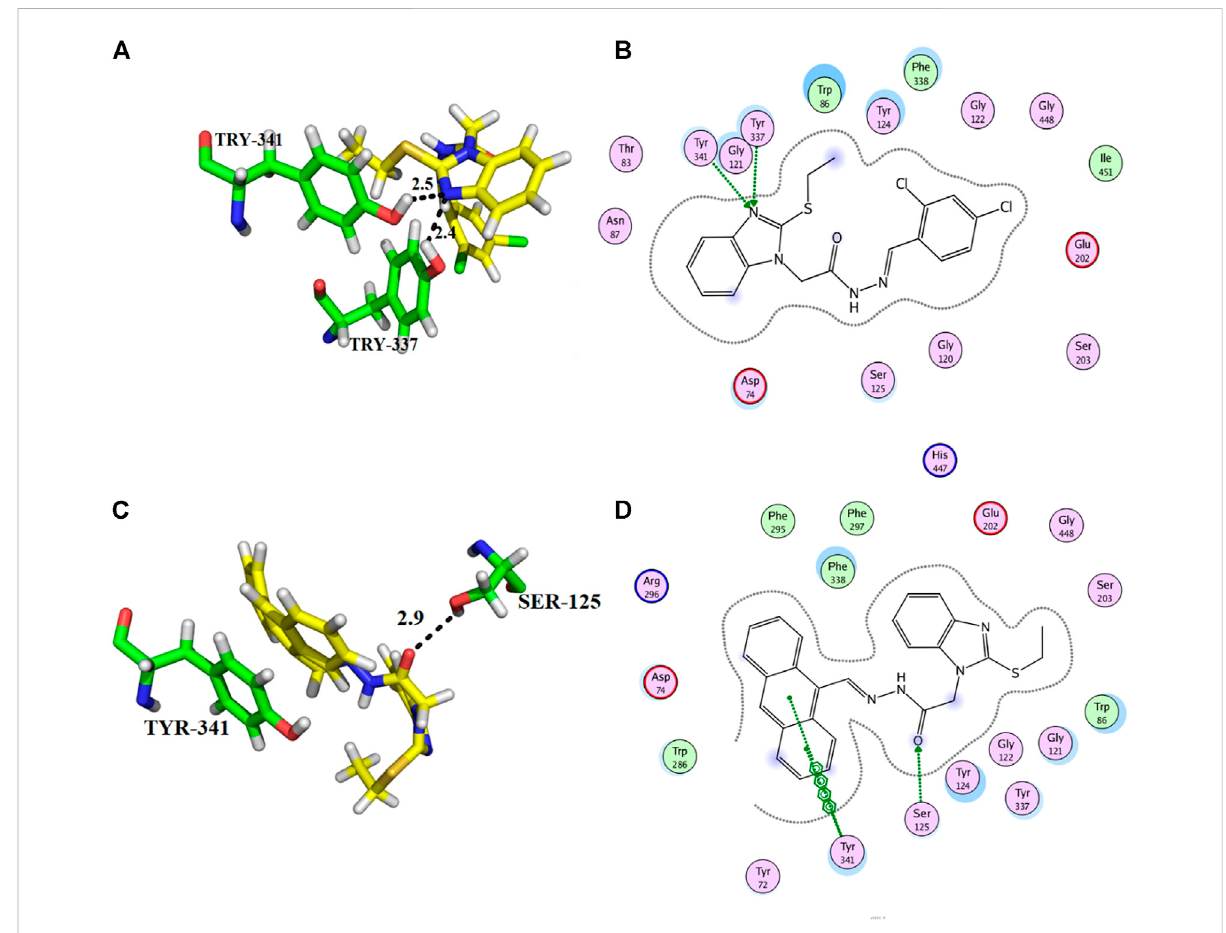
FIGURE 6 Showing the docking conformation of compound 10 (A,B) and 14 (C,D) in the active site of